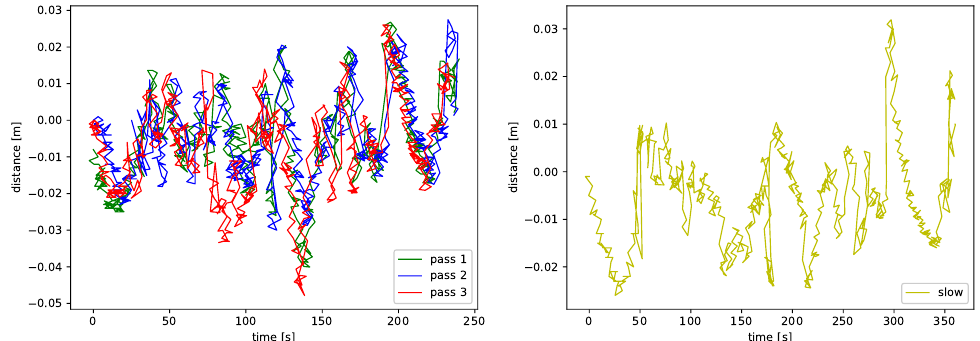
Figure 14. Displacement from the plan and the travelled paths in fast ( left ) and slow ( right )